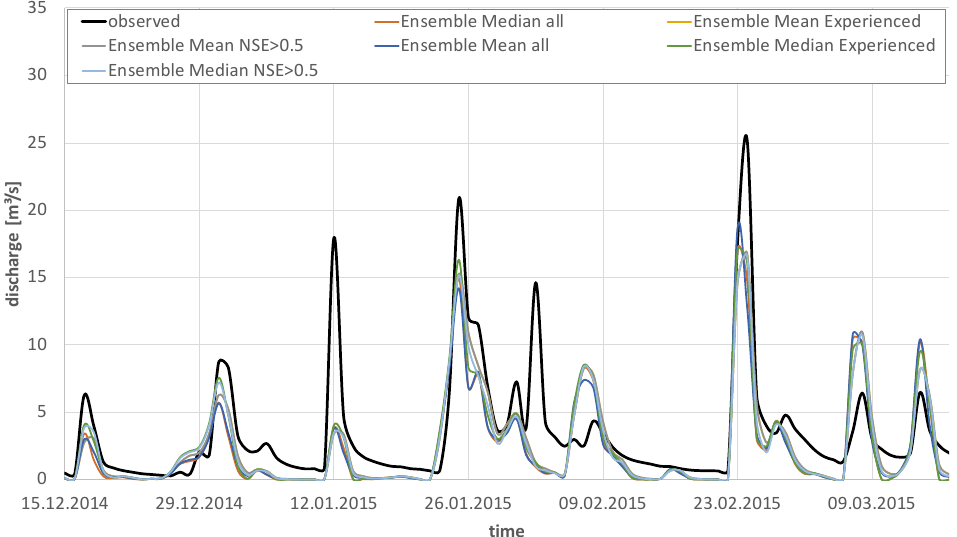
Figure 9. Variability of the discharges simulated by the investigated modellers’ ensembles against observations for three exemplary months of the rainy season of 2014/2015.